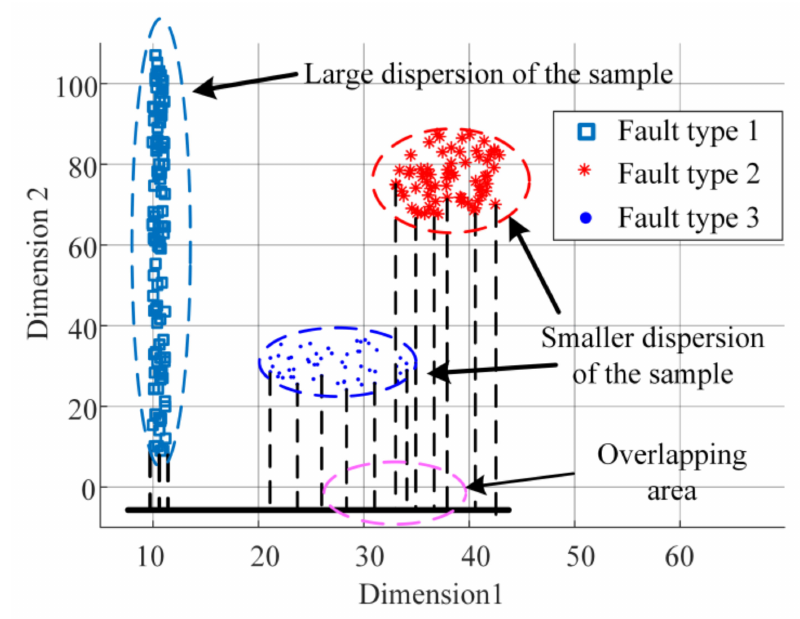
Figure 3. Classification of samples with different dispersion